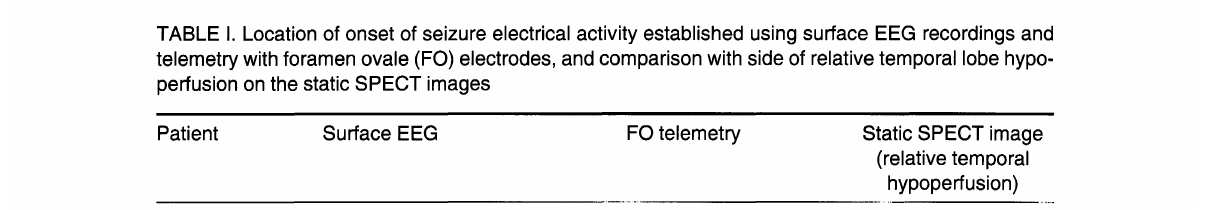
TABLE I. Location of onset of seizure electrical activity established using surface EEG recordings and telemetry with foramen ovale (FO) electrodes, and comparison with side of relative temporal lobe